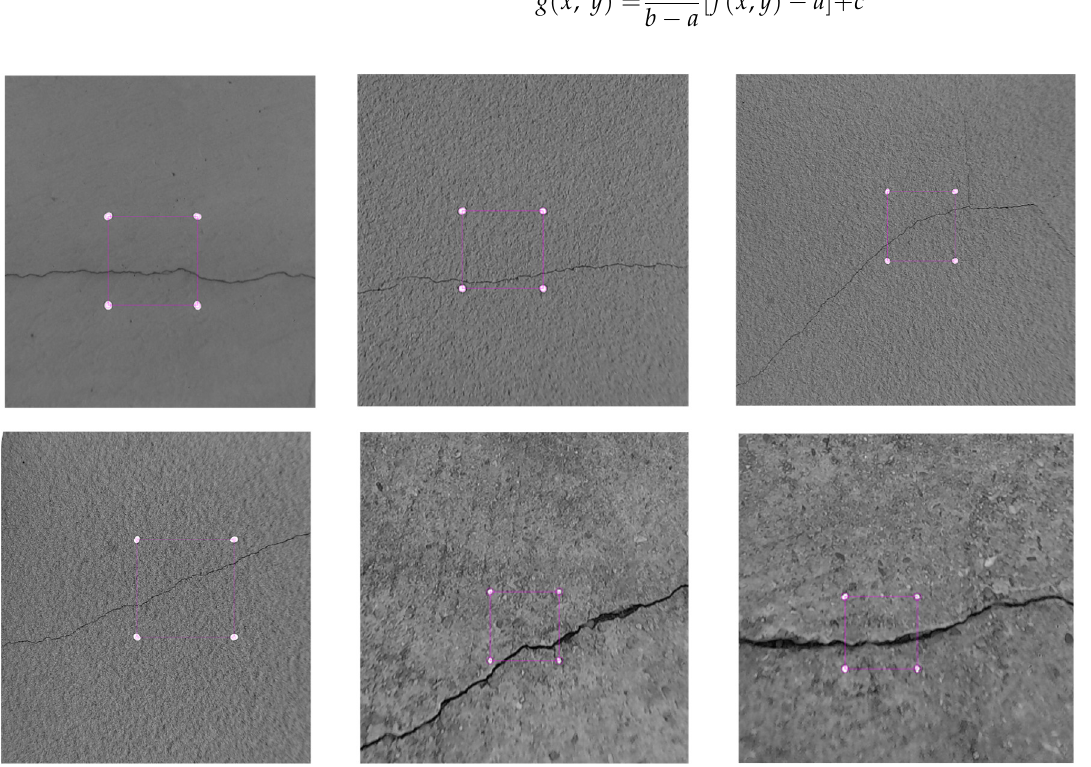
Figure 7. Crack image after gray processing.